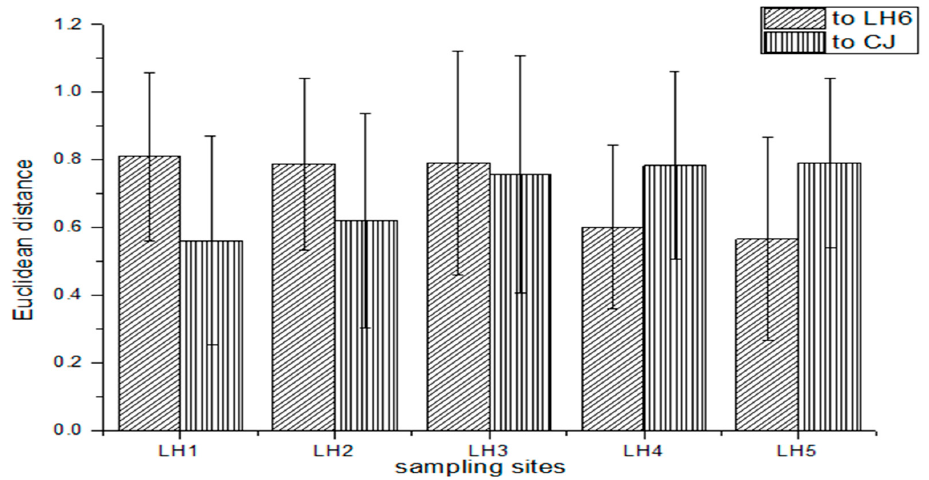
Figure 5. Comparison of the distance coefficient between the sampling site in LRB and the control sites of inflow and the YR from 2013 to 2015.